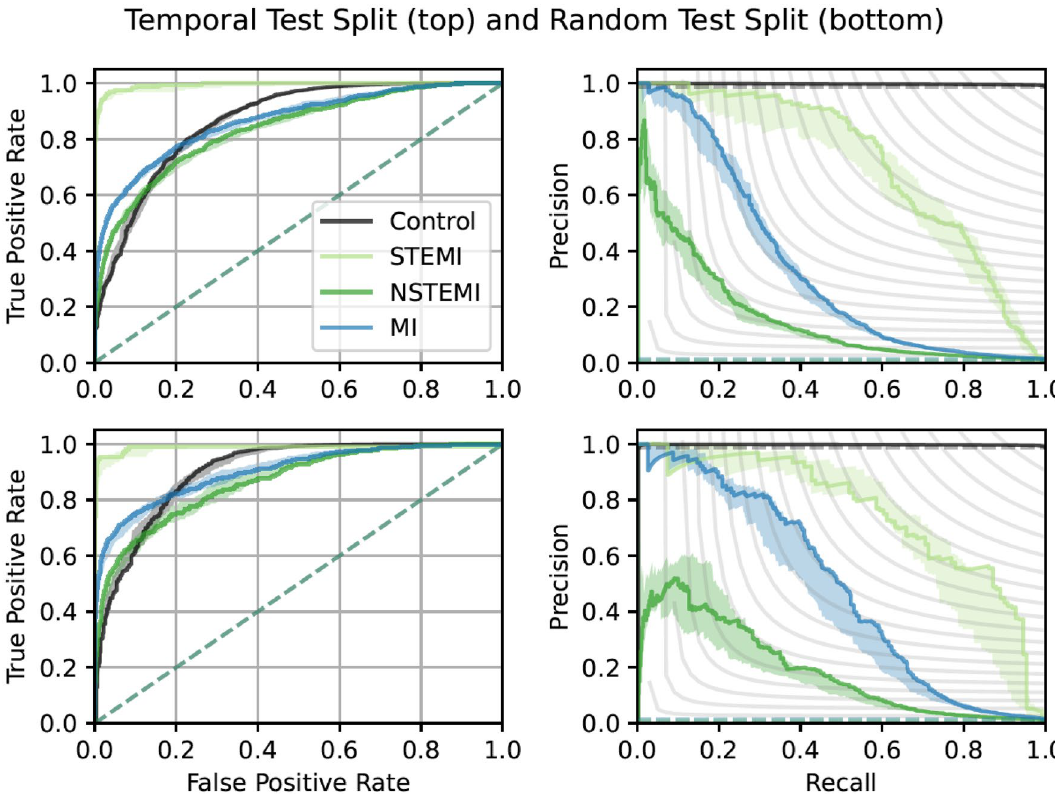
Figure 1. Receiver operating characteristics and precision-recall curves. Top row: Temporal test split. Bottom row: Random test split. Left column: Receiver operating characteristics curve. Right Column: Precision-recall curve. We show the curve with the median C-statistic or AP respectively as a solid line over-trained models with 10 seeds of our ensemble-based model. The shaded area shows the min and max values for all 10 models. The dashed lines indicate the curve corresponding to a random guess for the class in the given color according the legend. For the Precision-Recall curve this is a horizontal line at the value (number of positive examples)/ (number of all examples). Note that the worst-case curves are overlapping for NSTEMI, STEMI and MI in the precision recall curves due to the small fraction of positives (see dashed line close to the bottom). In the Precision-Recall curves the grey curves depict iso-F1 curves. Each curve is class vs all, where MI specifically is STEMI and NSTEMI vs